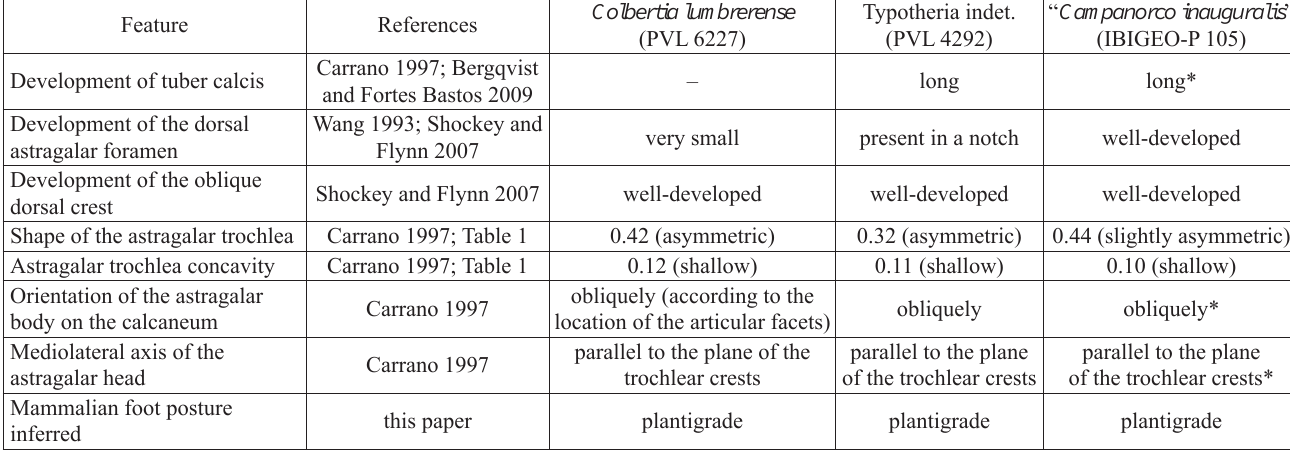
Table 2. List of tarsal features analyzed to infer the foot postures among the specimens herein reported. – not available; * approximate.